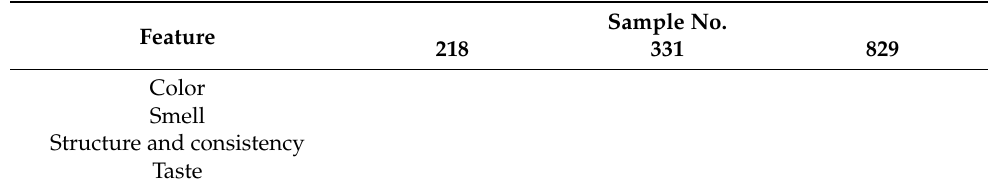
Table 6. Evaluation card for the 5-point rating scale.